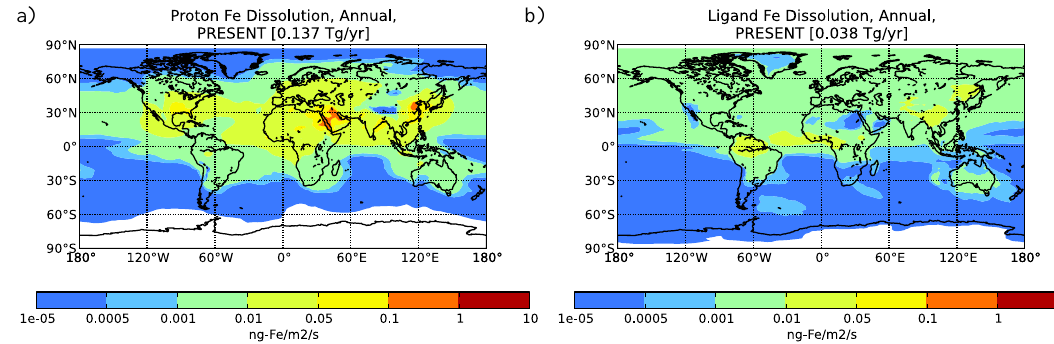
Figure 3. Annual averaged (a) proton-promoted and (b) ligand-promoted mineral-Fe dissolution flux (in ng-Fem − 2 s − 1 ) as calculated by TM4-ECPL for the present